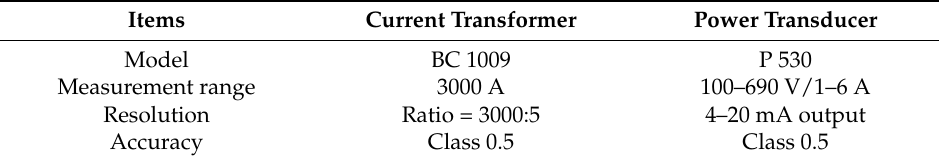
Table 3. Specifications of electric power measurement instruments.